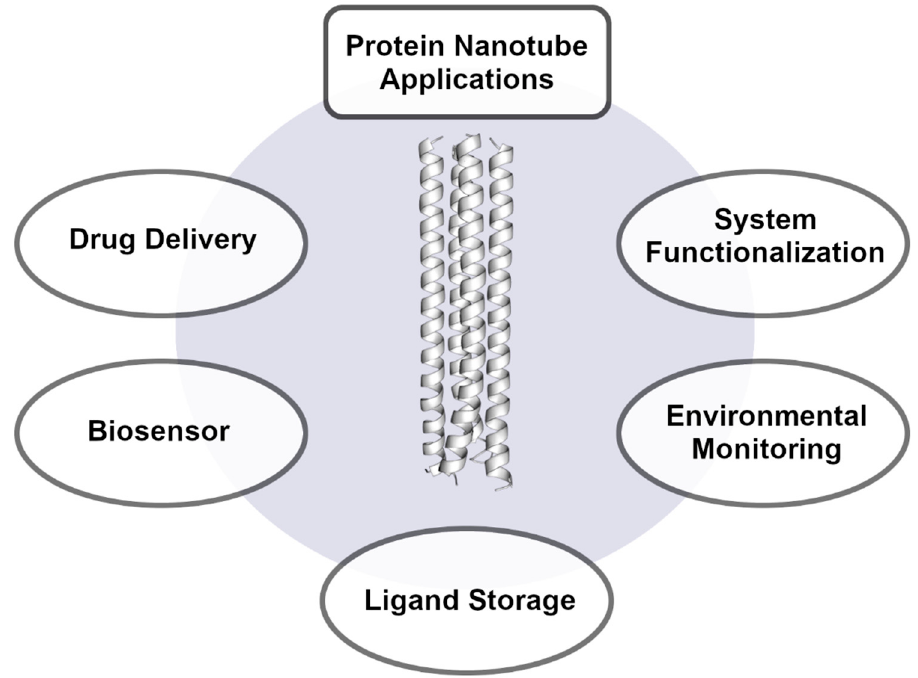
Figure 3. General applications for protein nanotubes in current use or development. These include but are not limited to drug delivery, biosensor, general ligand storage, environmental monitoring and system functionalization applications.